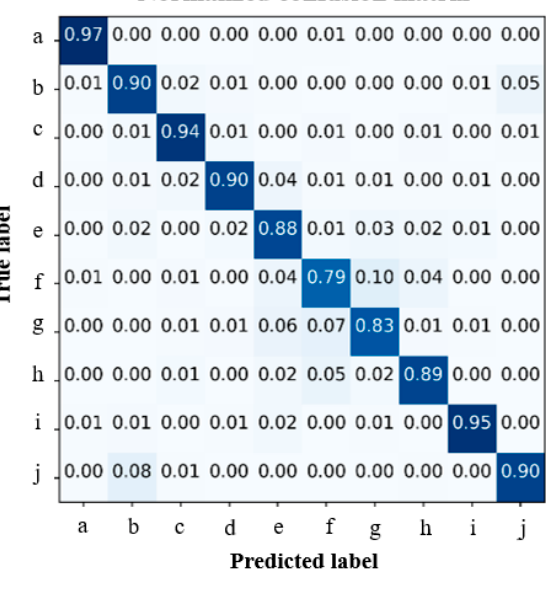
Figure 12. Classification accuracy expressed by confusion matrix obtained using all mixed data, where ( a ) grasp, ( b ) one, ( c ) two, ( d ) three, ( e ) four, ( f ) five (rest), ( g ) wrist flexion, ( h ) wrist extension, ( i ) okay, and ( j ) pinch .